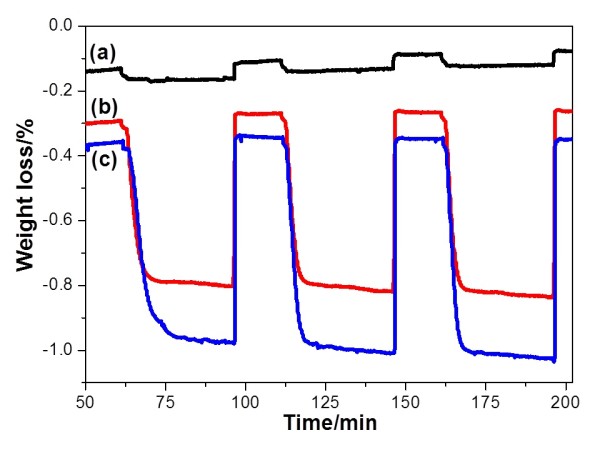
TG profiles of calcined samples ( 1 , 000 ° C , 20 h ) at 600 °C, which show oxygen release / storage properties. (a) CeO2, (b) Ce0.5Zr0.5O2, and (c) Ce0.5Zr0.3Al0.2O1.9.